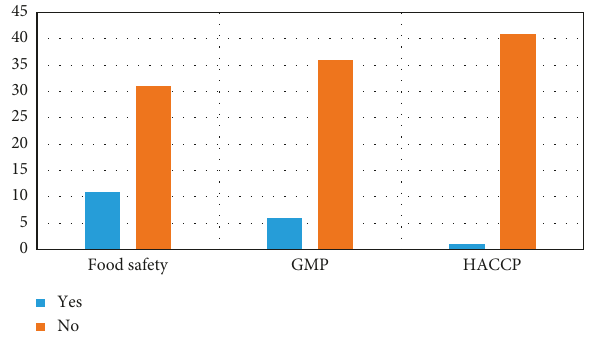
Figure 1: Types of training or workshop by the Ga kenkey producers.